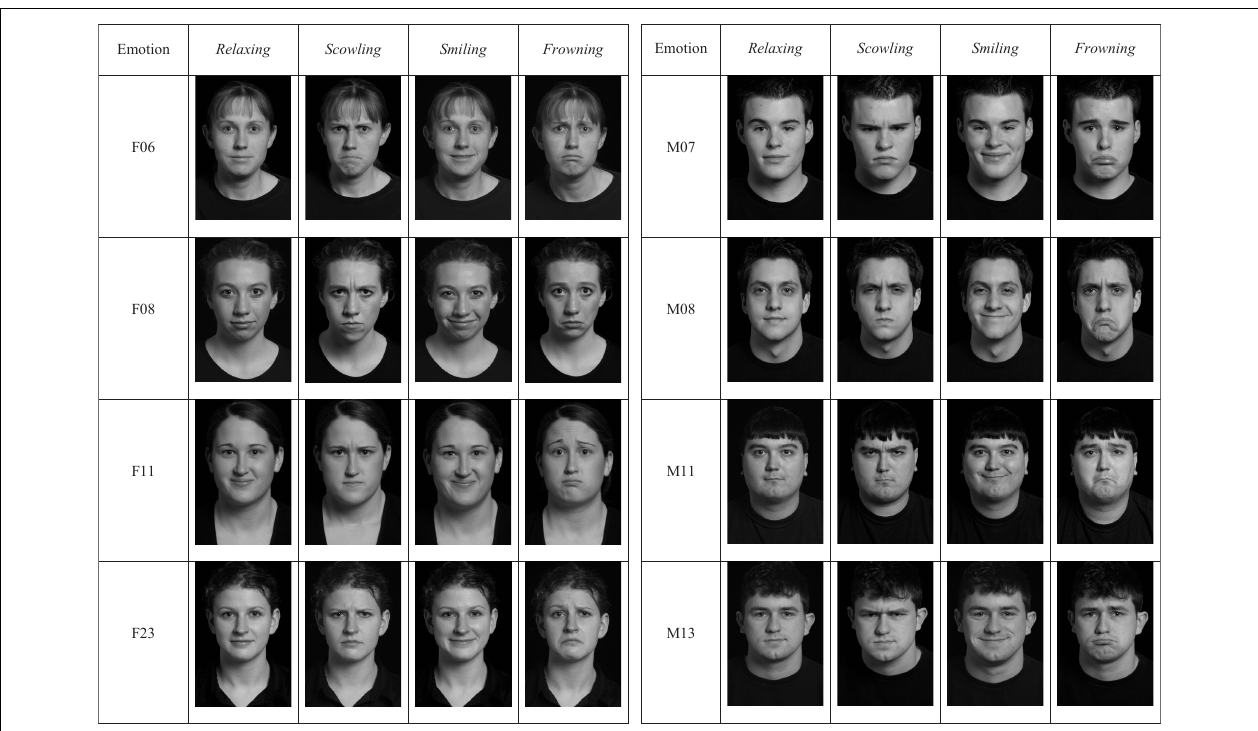
FIGURE 1 | Stimuli used in Experiment 2 (includes stimuli for Experiment